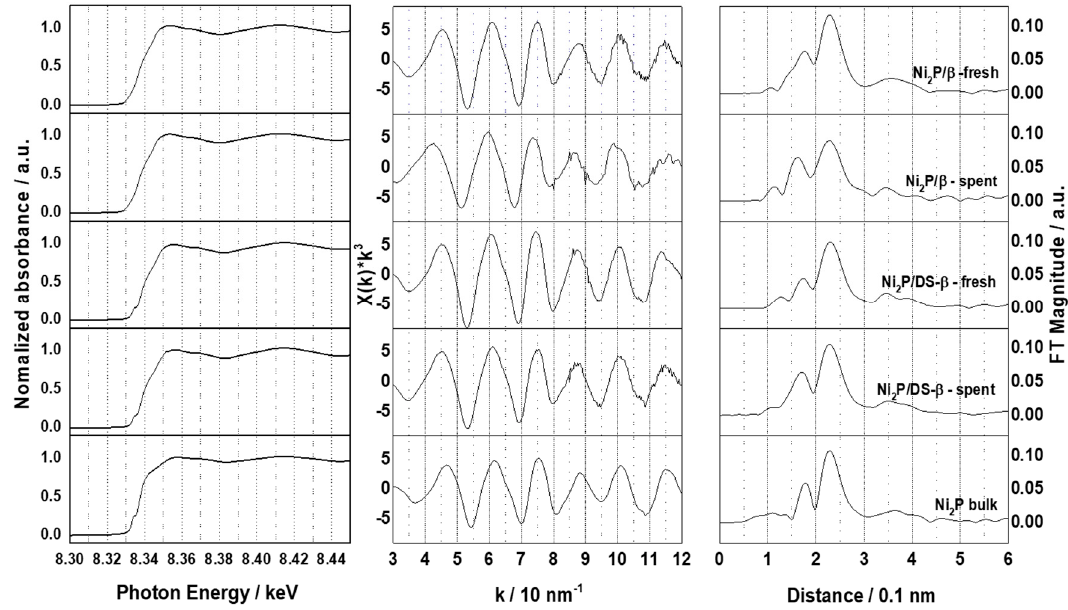
Figure 4. Ni K-edge extended X-ray absorption fine structure (EXAFS) spectra for the fresh and spent Ni 2 P catalysts and bulk Ni 2 P samples.